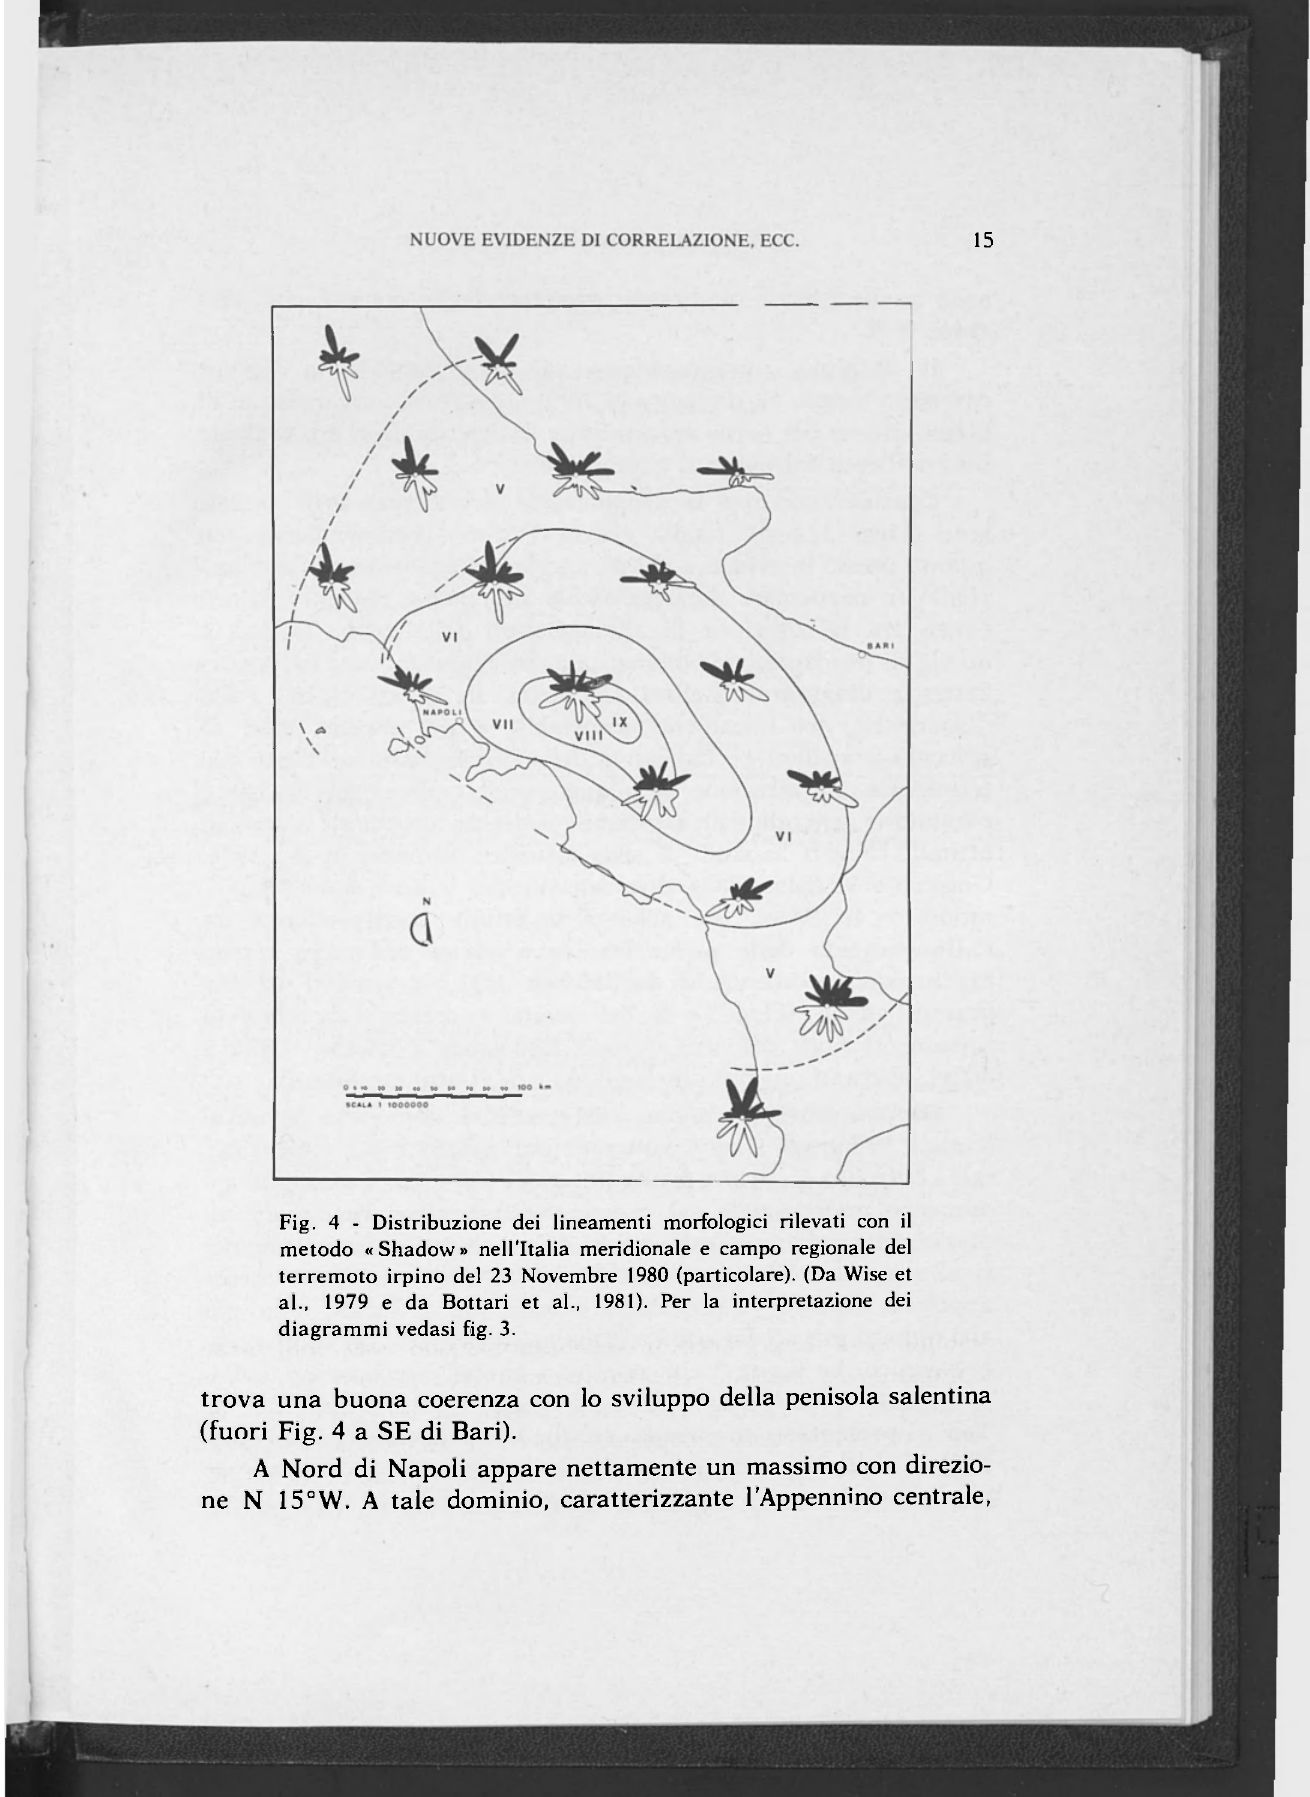
Fig. 4 - Distribuzione dei lineamenti morfologici rilevati con il metodo «Shadow» nell'Italia meridionale e campo regionale del terremoto irpino del 23 Novembre 1980 (particolare). (Da Wise et al., 1979 e da Bottari et al., 1981). Per la interpretazione dei diagrammi vedasi fig.